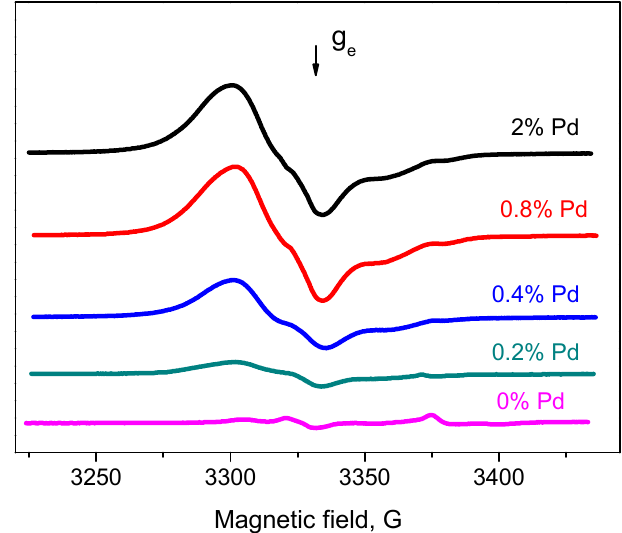
Figure 7. EPR spectra of TNB radical anions on the surface of x% Pd/ZrO 2 catalyst with various concentrations of the supported Pd (x, wt %). T act = 300 °C.